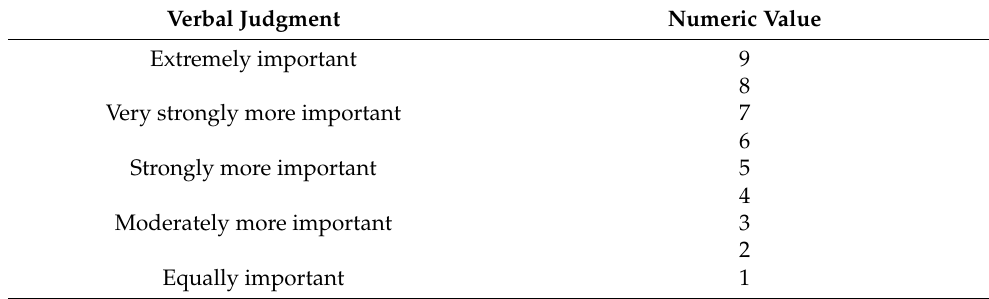
Table 1. Saaty’s pairwaise